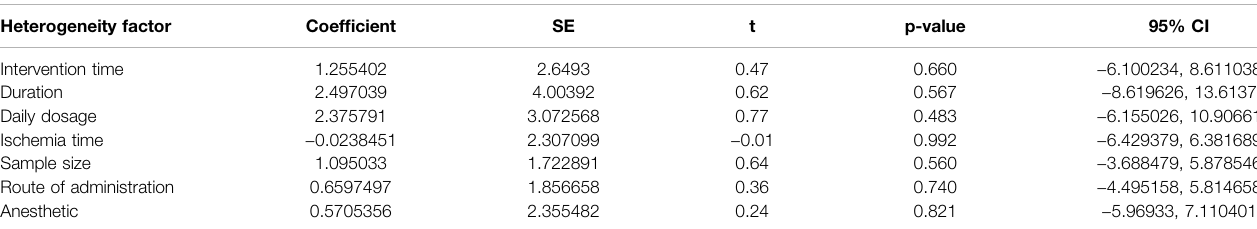
TABLE 4 | Meta-regression analysis of potential sources of